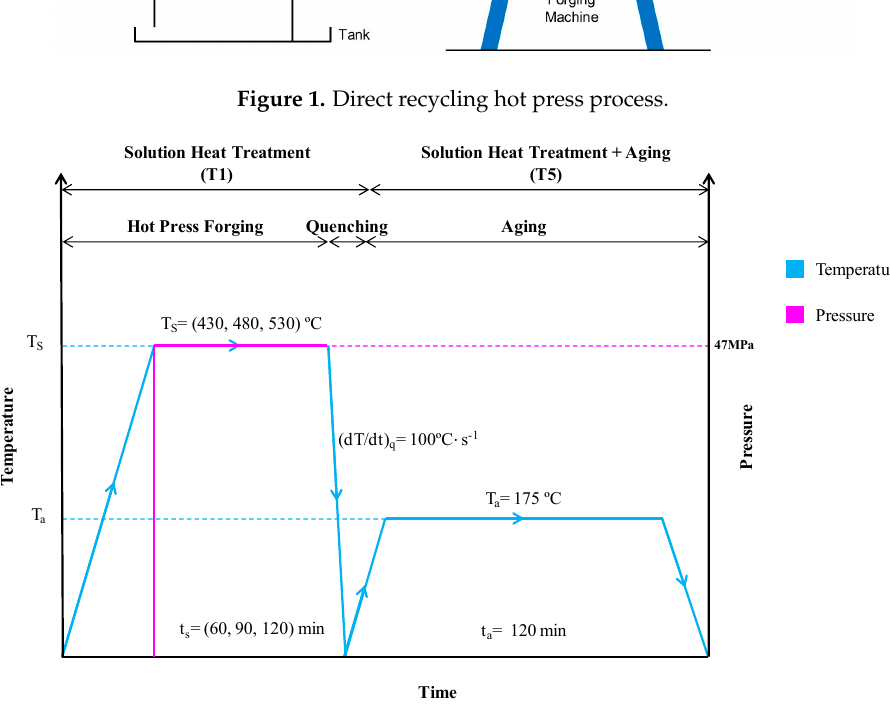
Figure 2. Direct recycling hot press diagram. Table 2. Sample designation for different parameter